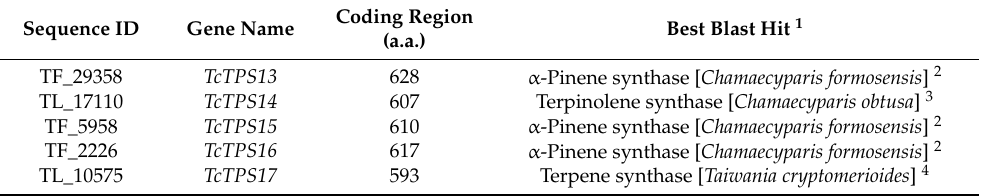
Table 1. Summary of T. cryptomerioides monoterpene synthases identified in this